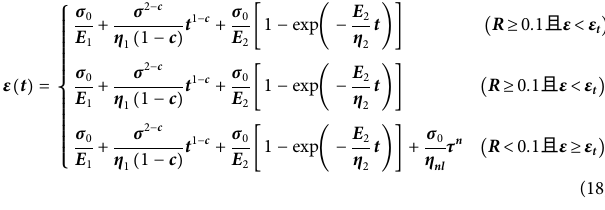
Frontiers in Earth Science |